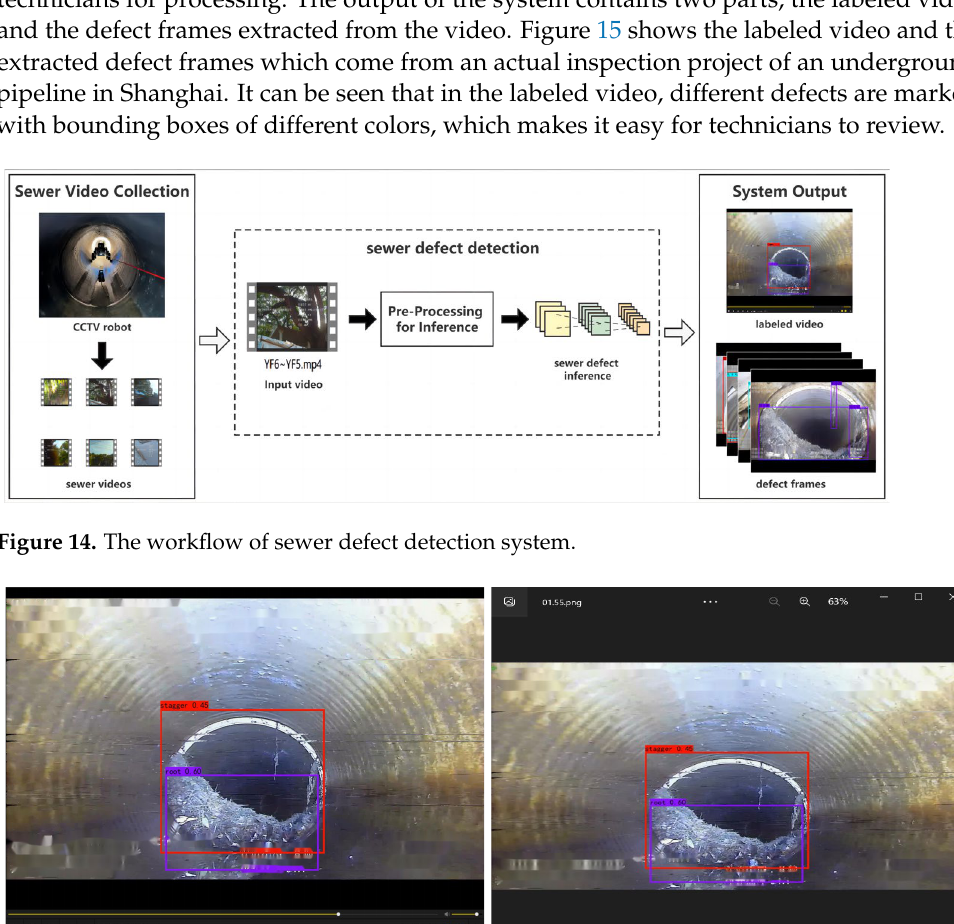
Figure 13. Examples of false detected defects. ( a ) crack misidentified as deposition ; ( b ) crack misi- dentified as stagger ; ( c ) crack was not detected.